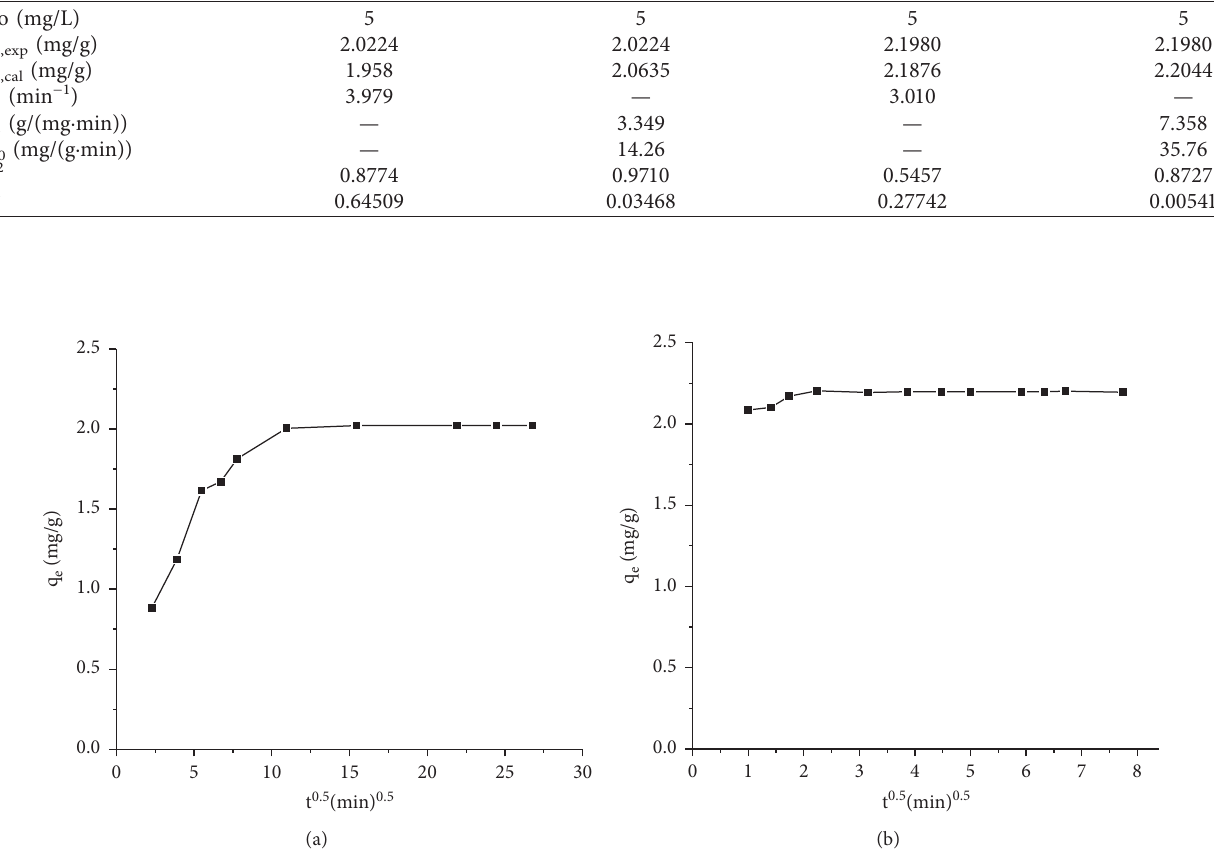
Figure 7: Intraparticle diffusion plots of Cr(VI) adsorption on (a) TR and (b) PSS (initial concentration of Cr(VI) 5mg/L, adsorbent dosage 2.5g/L, shaking speed 200rpm, temperature 25 ° C, and pH 2).